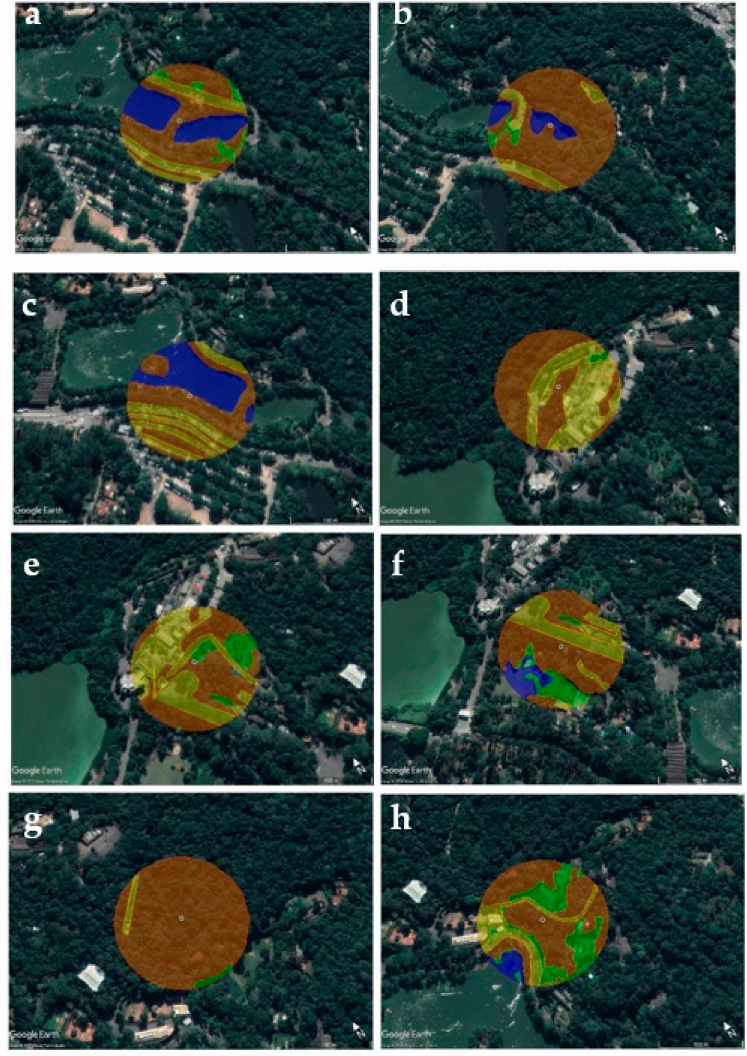
Figure 2. Sampling areas in S ã o Paulo Zoo: site PO ( a ), site R69 ( b ), site L70 ( c ), site EX ( d ), site BA ( e ), site FM ( f ), site R113 ( g ), and site R61 ( h ). Small circles in the center indicate the exact point where the Center for Disease Control (CDC) traps were installed. Buffers extending 200 m diameter were created around each sampling site to define the surrounding landscape. Yellow represents areas where there is human activity (paving and edification), blue represents lake area, green shows bush/sand/grass areas, and orange shows forest